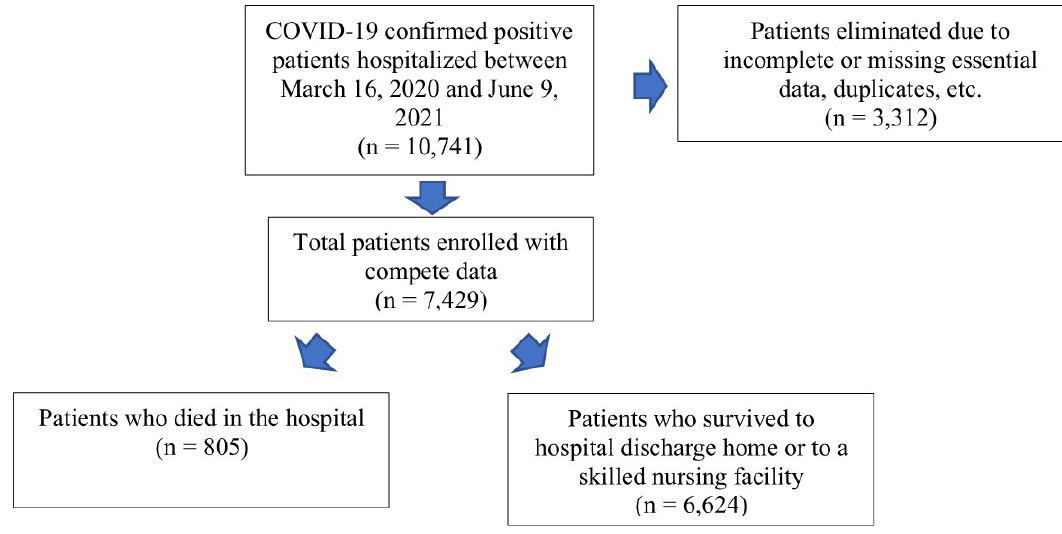
Fig 1. Patient enrollment and overall